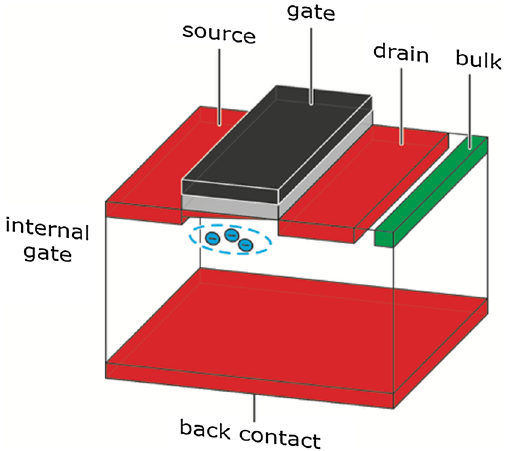
Fig. 1 The expected recoil spectrum for a non-relativistic dark matter elastic cross-section of σ e = 10 − 41 cm 2 as a function of the deposited energy E e and the ionization Q . The rate is shown for incoming dark matter particles with a mass of 1GeV (green, dashed), 10MeV (black, solid) and 5MeV (red, dotted). We assume standard astrophys- ical assumptions for the dark matter density and velocity distribution (The dark matter density is set to 0 . 4GeV / cm 3 , a Maxwell–Boltzmann velocity distribution for the dark matter particles is assumed with 300km / s as mean velocity and the escape velocity is set to 600km / s.) The form factor F DM is set to one